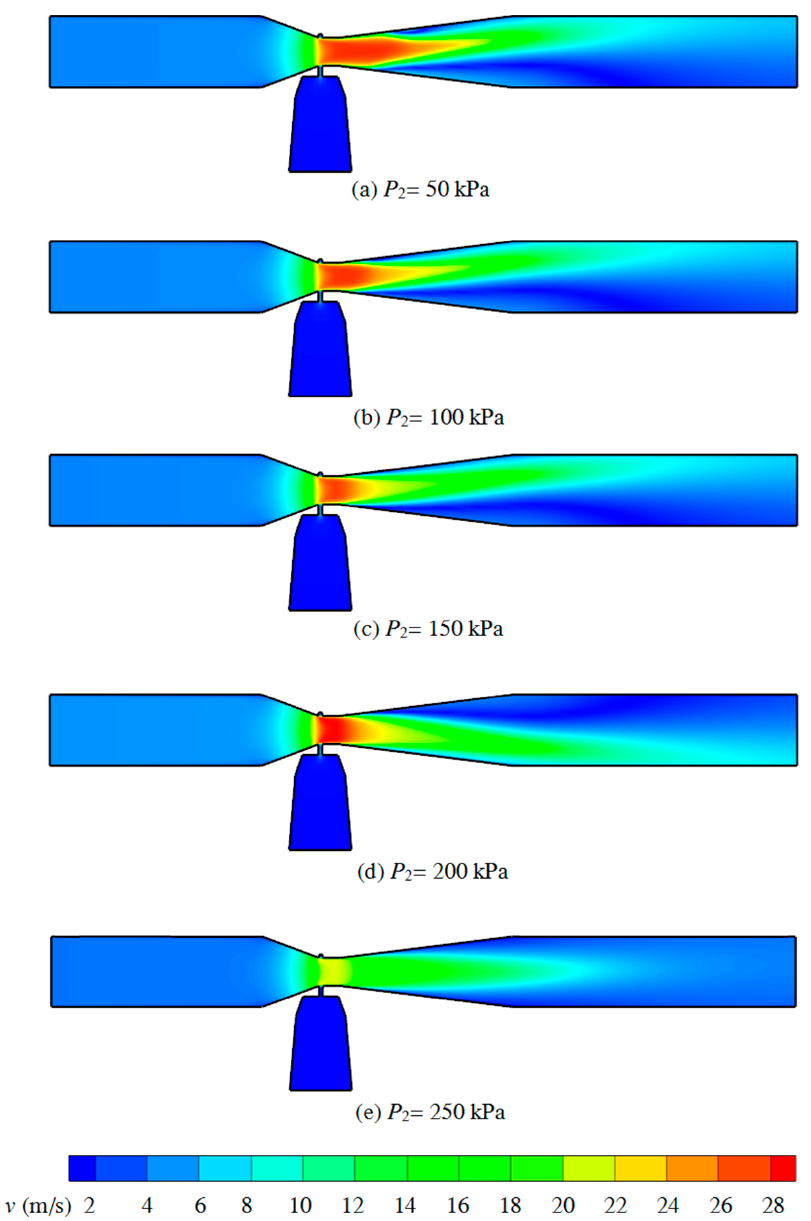
Figure 7. Velocity contours in the z = 0 section.